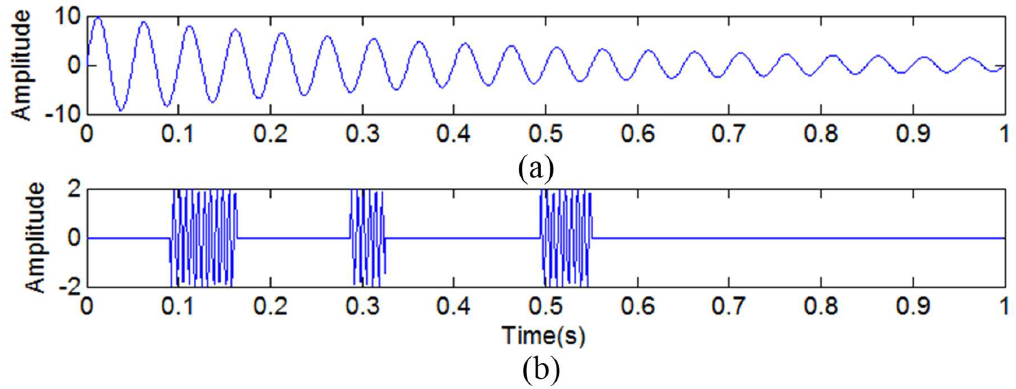
Figure 15. The simulated signals. ( a ) The simulated signal y 11 ( t ); ( b ) the simulated signal y 12 ( t ).